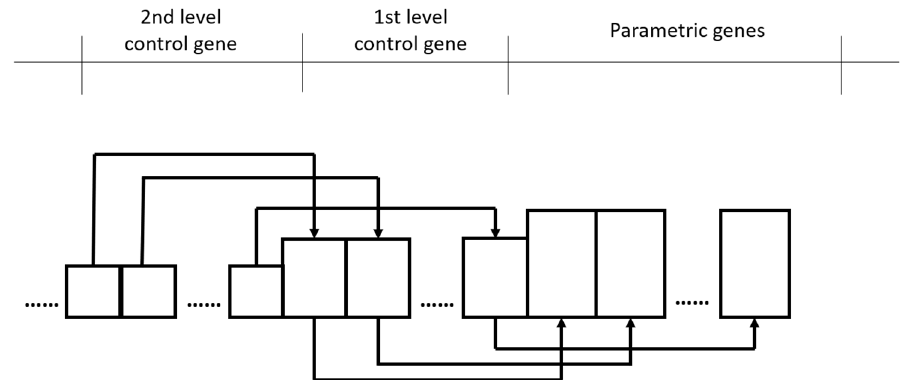
Figure 4. Hierarchical structure of the chromosome.